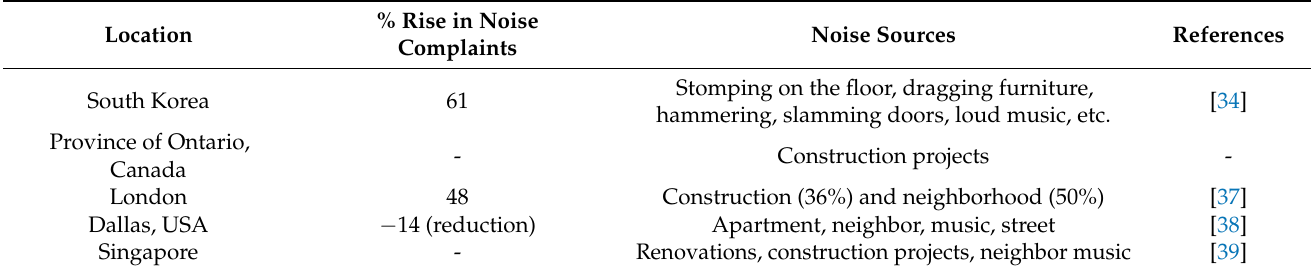
Table 2. A summary of rising in noise complaints during COVID-19 pandemic and possible noise sources.